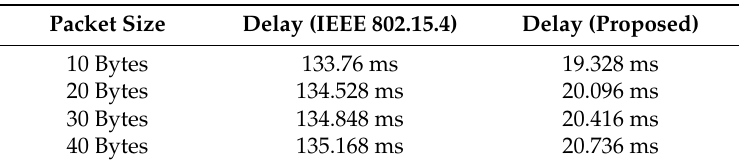
Table 3. Minimum achievable delay of co-related medical traffic in case of emergency events for the proposed and conventional schemes according to the packet size (best case).